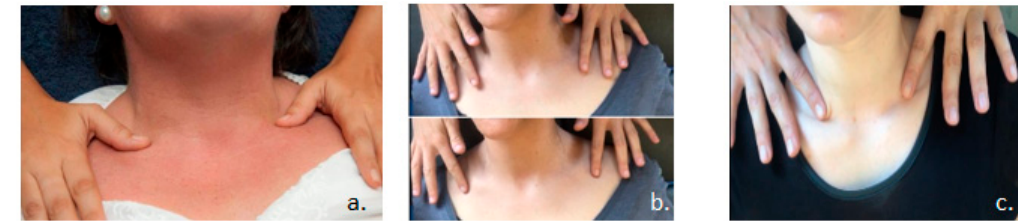
Figure 1. ( a ) Dr. Godoy maneuver, cervical stimuli, ( b ) Terminus Dr. Vodder, ( c ) Placebo maneuver.